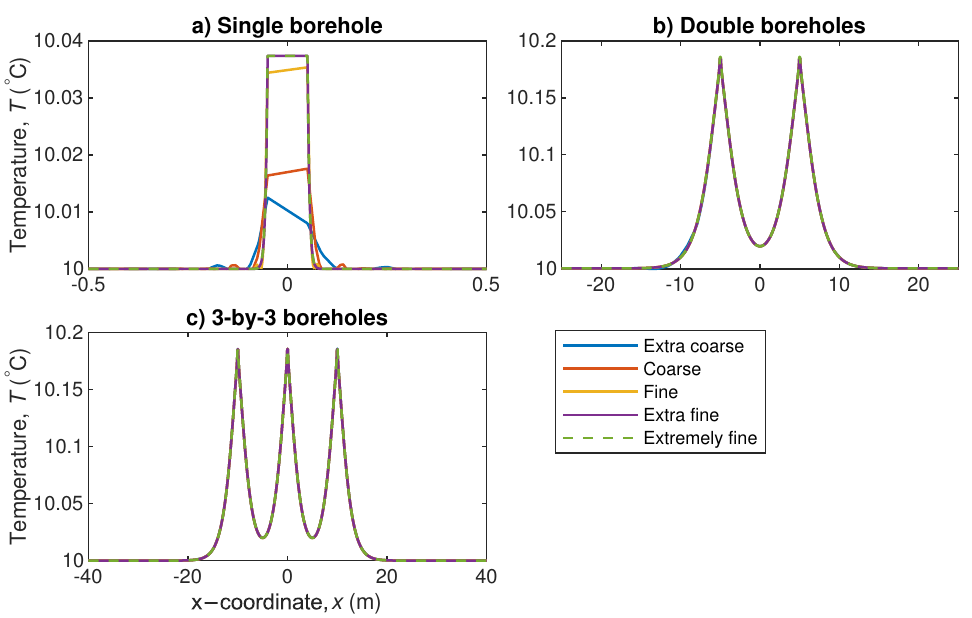
Figure A1. Temperature distribution over the x -coordinate (i.e., the line y = 0) for single, double, and 3-by-3 boreholes in spring ( t = 3 (mon)) for different mesh counts. Figure A1 shows the temperature distribution over the x -coordinate (i.e., the line y = 0) for single, double, and 3-by-3 boreholes in spring ( t = 3 (mon)) with the five numbers of mesh elements. As can be seen, inconsistent results are found in the three coarser mesh counts (that is, extra coarse, coarse, and fine), particularly in the single borehole scenario. However, the temperature distribution of all the three borehole arrangements remains the same while discretizing the domain with the two finer meshes (that is, extra fine and extremely fine). As a consequence, the extra fine option is selected to be the optimal mesh count for this